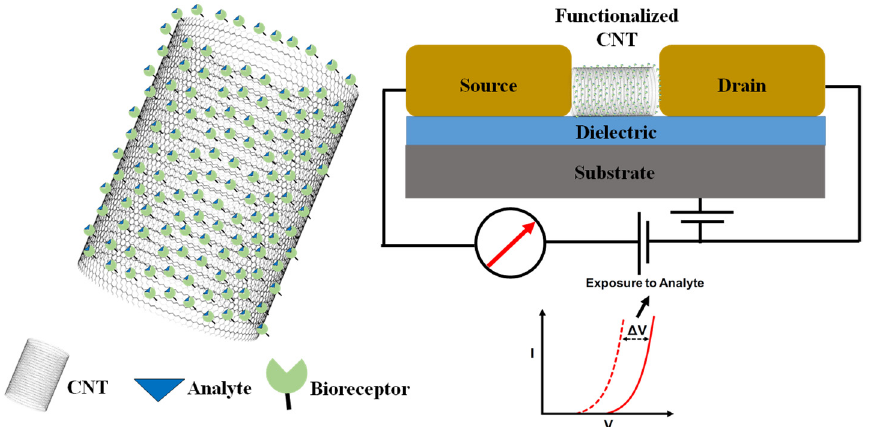
Figure 5. Schematic of carbon nanotube (CNT) functionalized with bioreceptors to facilitate the capture of specific analyte. Schematic of CNT-based field-effect transistor. Successful capture of analyte molecule leads to shift in threshold voltage of the FET device, which is in indirect measure of analyte concentration.